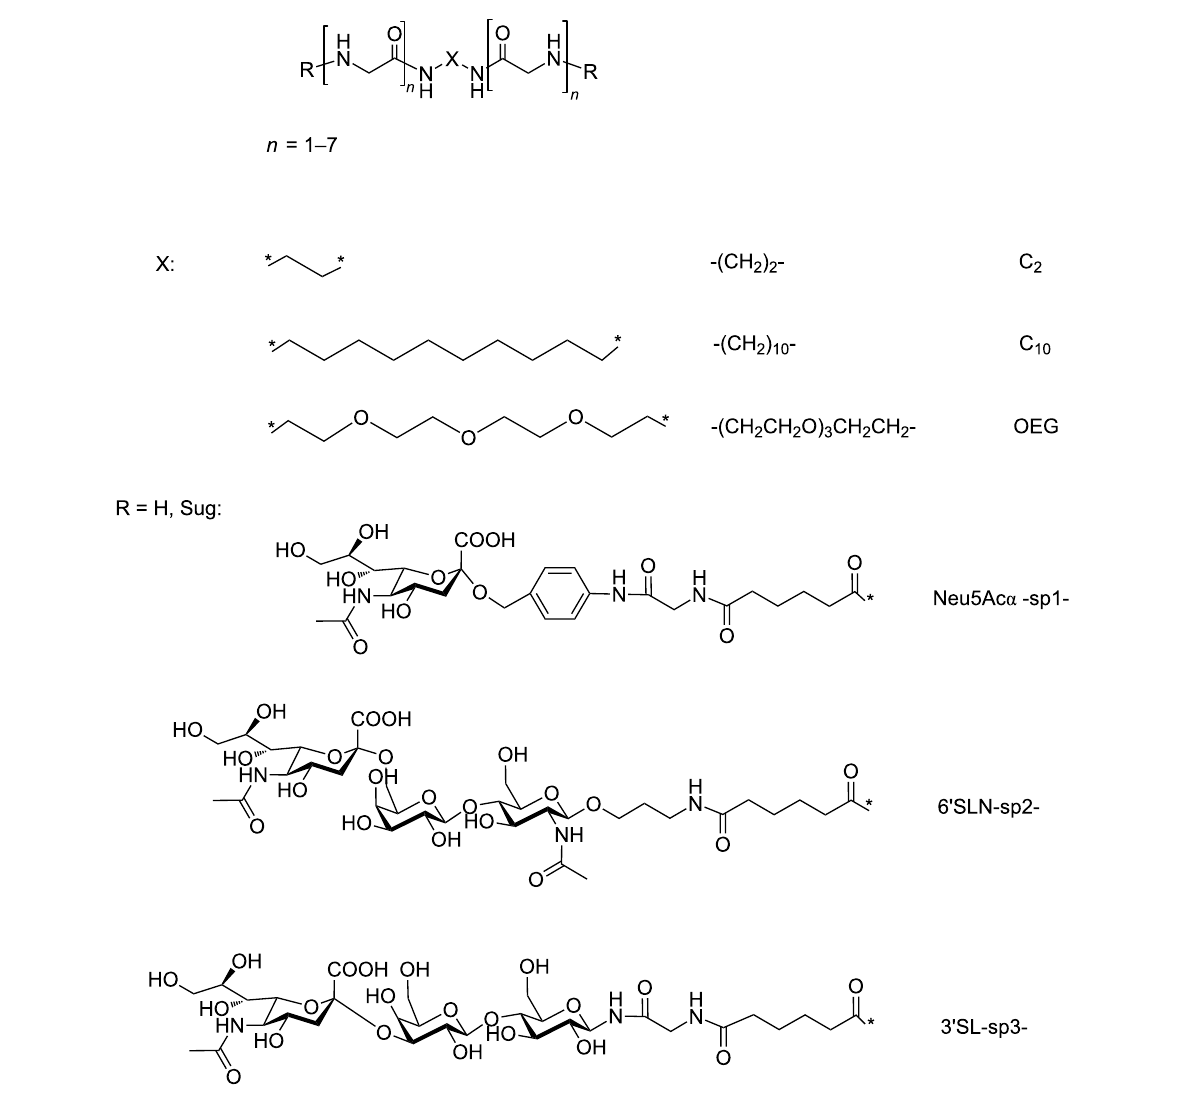
a layer are packed by polyglycine II type (PG II) [4,5]. Their helical polypeptide chain fundamentally differs from the canon- ical α -helix. The association of symmetrical tetra- and trianten- nary (star-like) oligoglycines spontaneously proceeds only when the number of glycine (Gly) residues in a chain ( n ) is equal or greater to seven. Oligoglycines with an antennae size less than seven do either not associate at all or require extremely favorable conditions, in particular surface